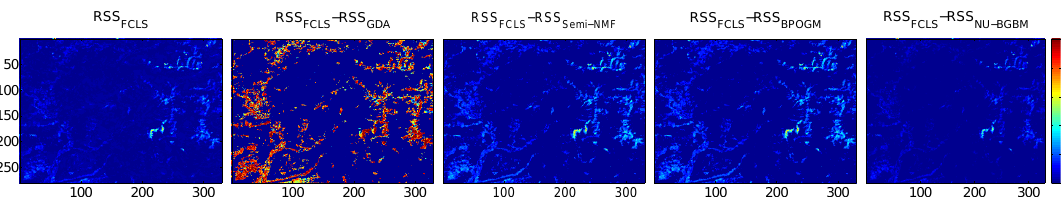
Figure 8. Extracted endmembers of gulf of Lion.